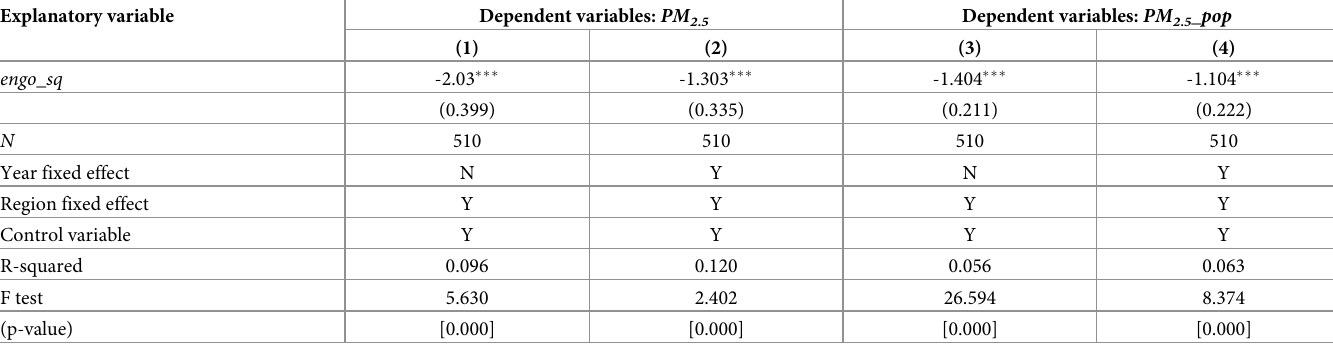
Table 5. PM2.5 emission reduction effect of ENGOs.